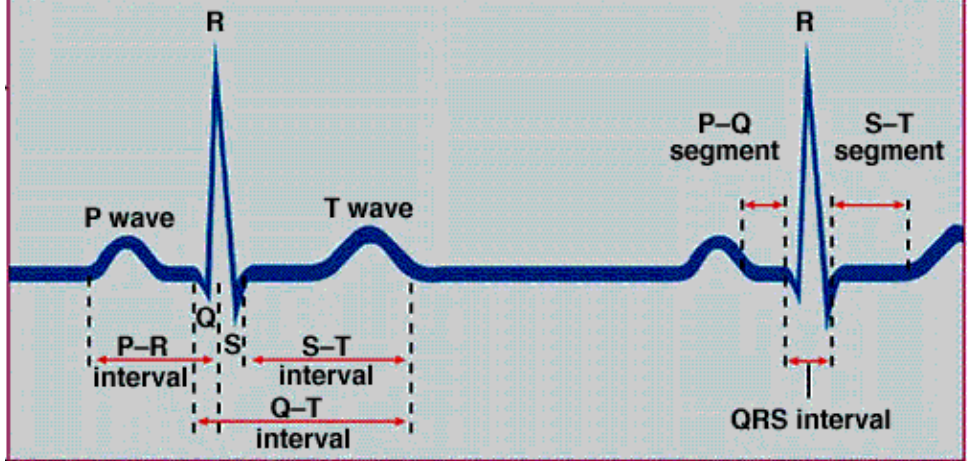
Figure 3. ECG wave and intervals [37]. in the ESP32